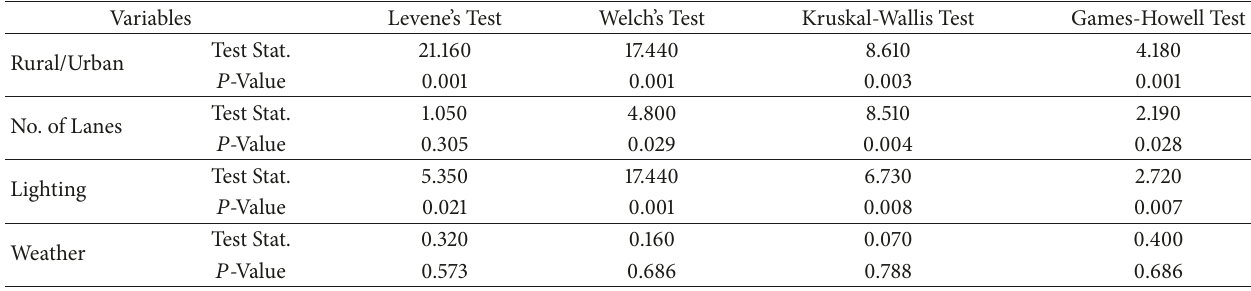
Table 8: Test for equality of mean, homogeneity of variances, and similarity in distribution of the wet pavement crashes across the categorical variables.